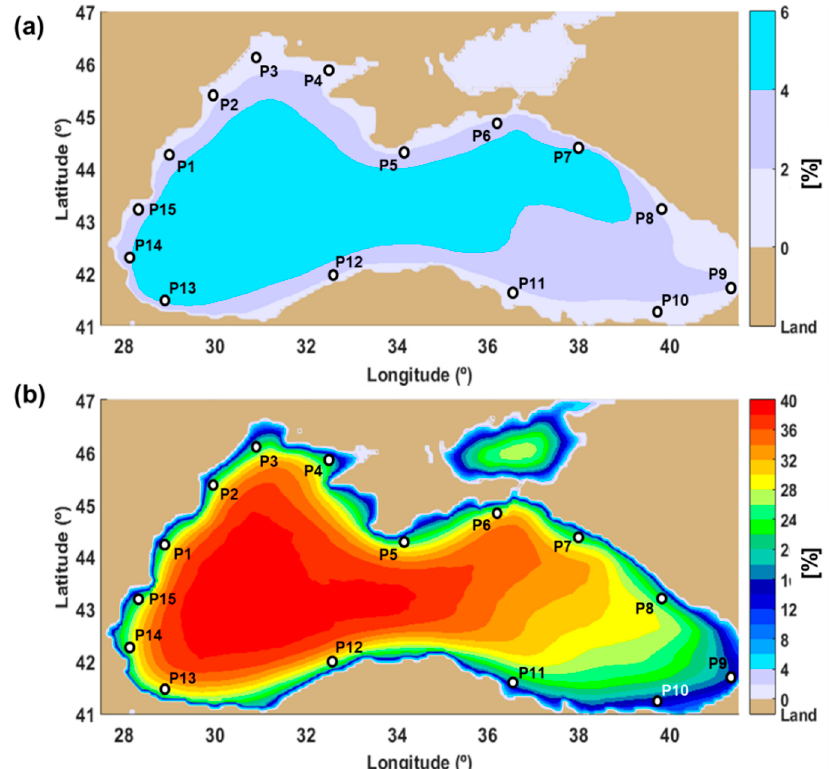
Figure 2. The spatial distribution of the significant wave height ( Hs ), as resulted from the 30-year Simulating Waves Nearshore (SWAN) simulations (1987–2016). Results reported for: ( a ) Hs > 2.5 m (in %); ( b ) Hs > 1 m (in %).